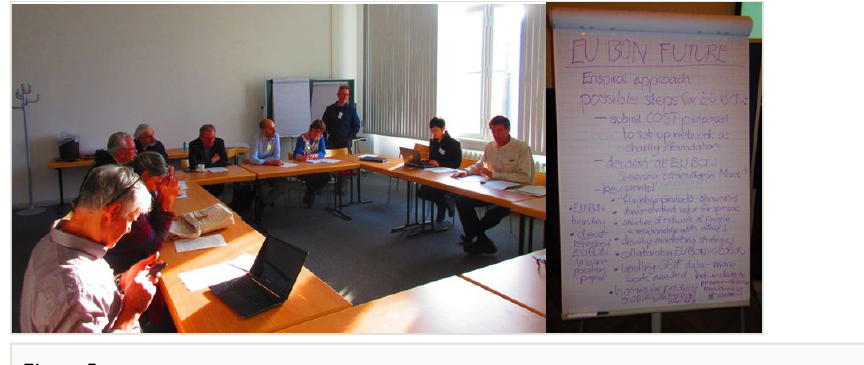
Group 2 discussion: Strategies, Business Plan and EU BON sustainability (Credits: F. Wetzel)